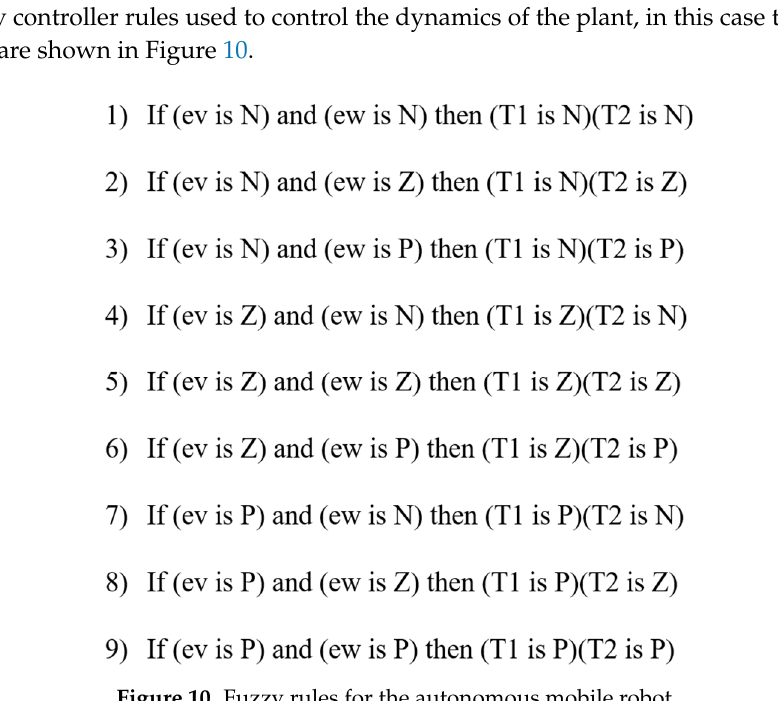
Figure 10. Fuzzy rules for the autonomous mobile robot.